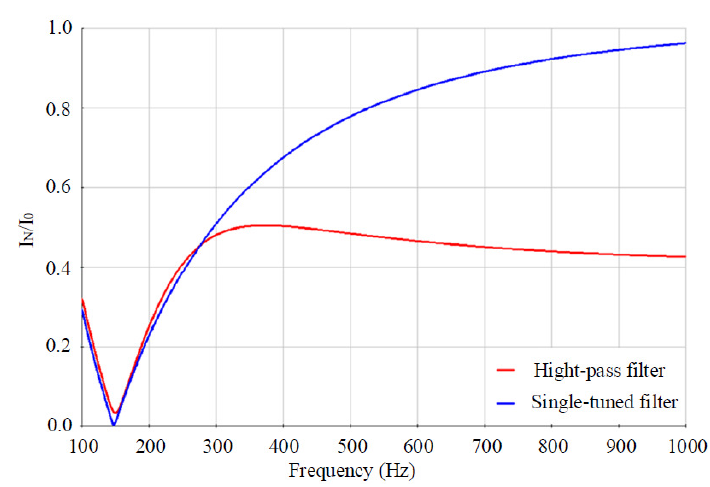
Figure 6. Harmonic current transmission coefficient.